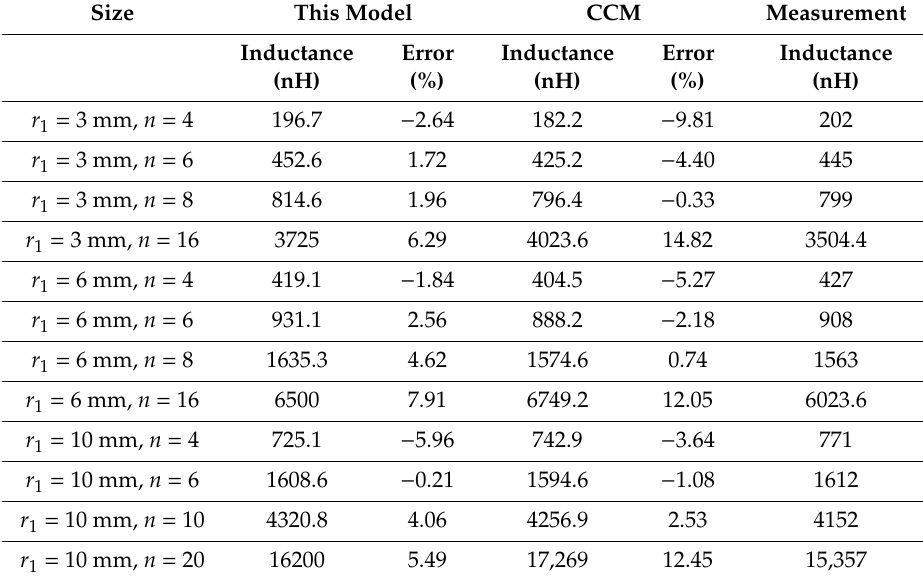
Table 3. Comparison of the inductance